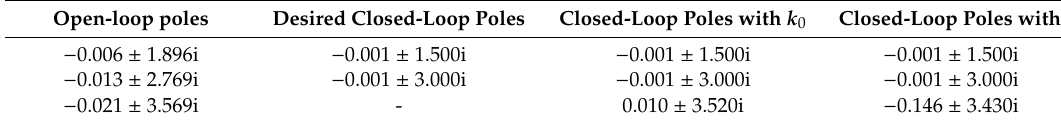
Table 3. Gains (test-case 1).